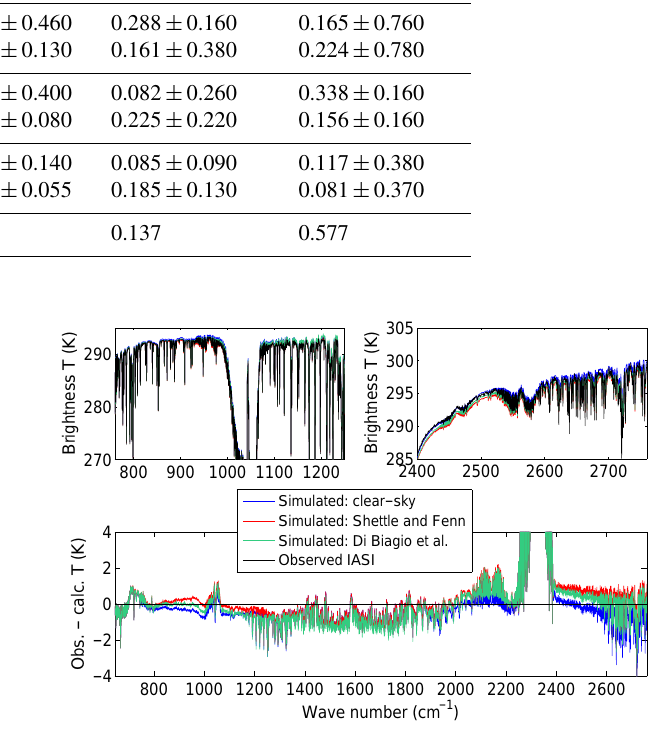
Figure 9. Top and bottom panels: same as middle and bottom panels of Fig. 8, for the case of 28 June (medium aerosol load). Average residuals are computed over 15 IASI soundings.